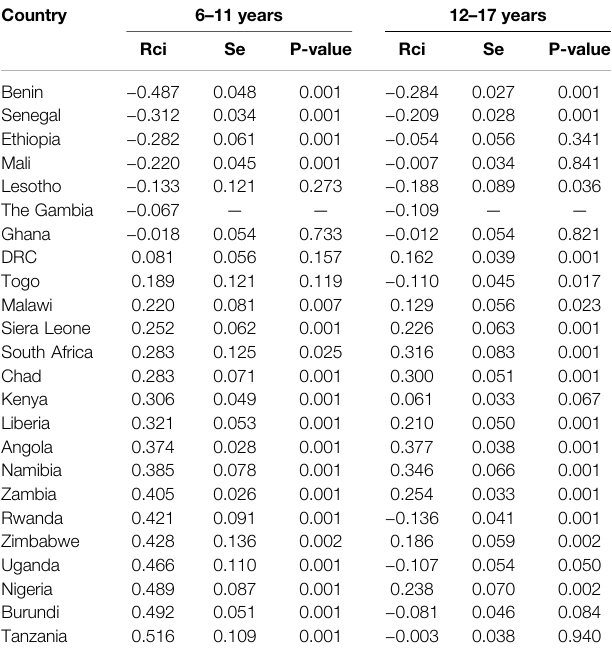
TABLE 5 | Relative concentration index in school enrolment by age group.